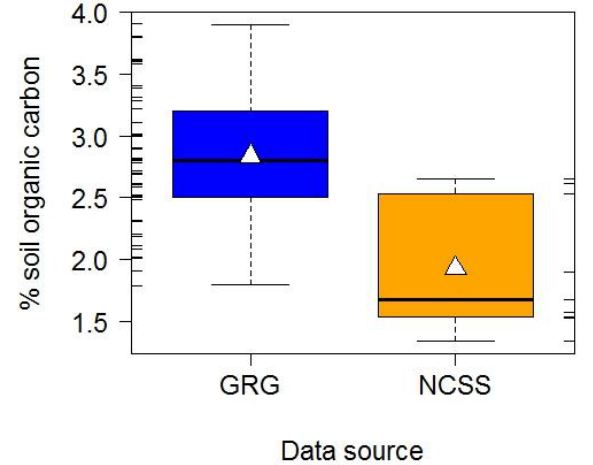
Figure 3. Box-and-whisker plot comparing soil organic carbon (SOC) in this study (Grand River Grasslands, GRG) to eight samples of cultivated soils (six Armstrong soil samples and two Gara soil samples) reported online by the National Cooperative Soil Survey [33]. Tick-marks just inside the left and right axes denote the distribution of individual samples for the GRG and NCSS, respectively. Open triangles denote means. All samples were 0 to 15-cm sampling